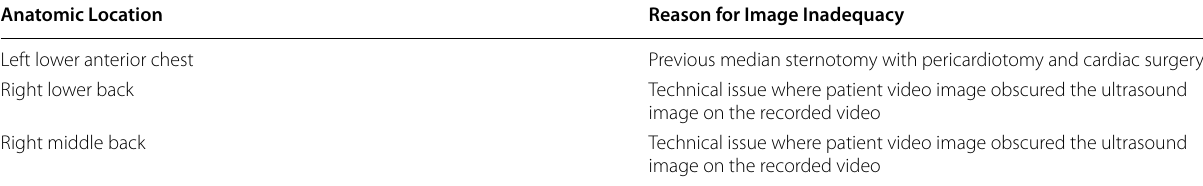
Table 4 Suspected reasons for inadequate quality images Anatomic Location